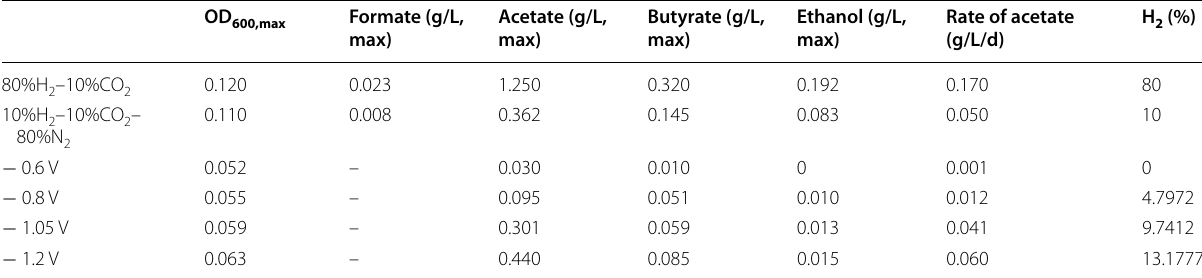
Table 1 Results of hydrogen autotrophic fermentation and microbial electrosynthesis experiments OD 600,max